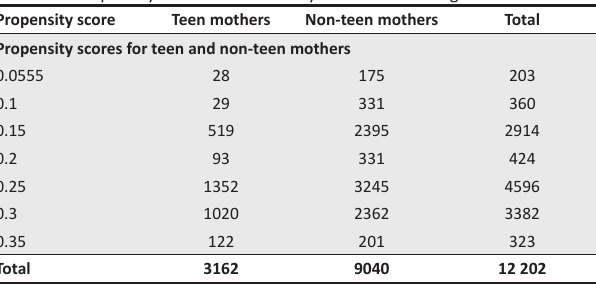
TABLE 4a: Propensity scores and summary result of matching assessment. Propensity score